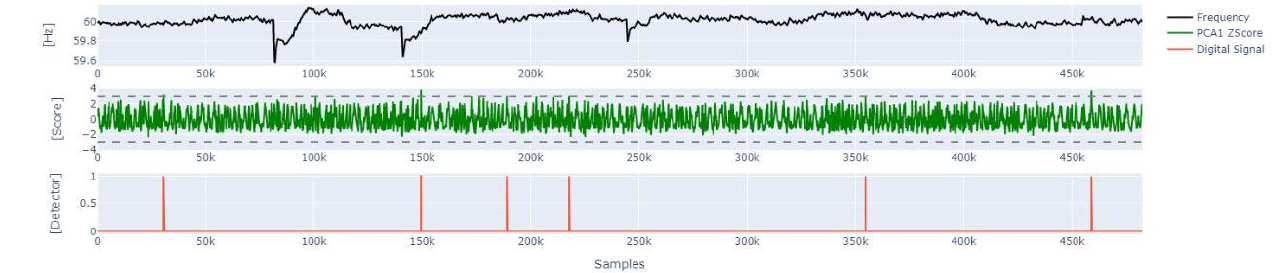
Figure 15. Event 2: detector event of PMU Bateias (located at Parana State).